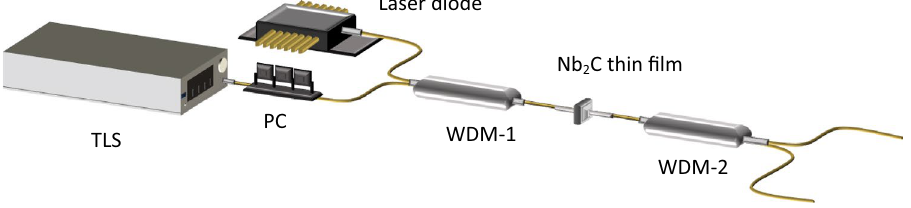
Figure 4. Experimental setup for polarization modulator utilizing Nb 2 C thin